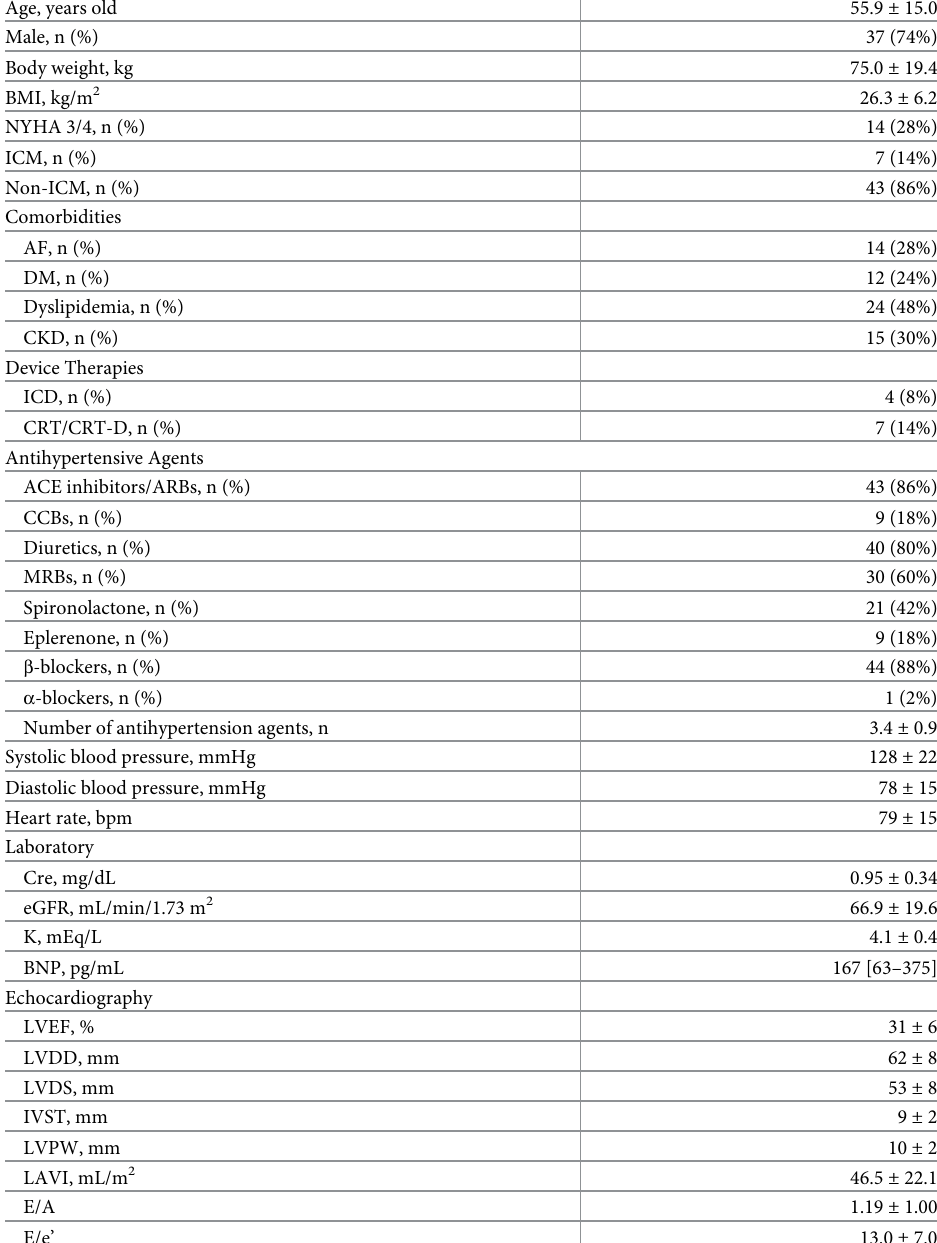
Table 1. Baseline patient